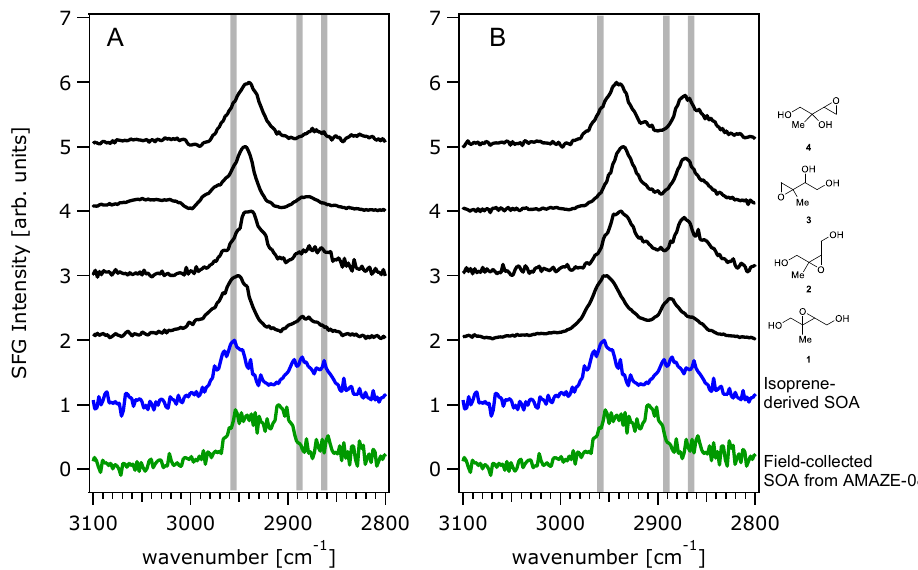
Fig. 2. ssp-Polarized SFG spectra of vapor-phase (left) and spin-coated (right) epoxides in contact with fused silica and comparison to synthetic isoprene-derived SOA particles (blue) and SOA particles collected in the central Amazon Basin (green). From top: α -IEPOX (4), δ -IEPOX (3), cis- β -IEPOX (2), trans - β -IEPOX (1), synthetic isoprene-derived SOA, and natural SOA from the central Amazon Basin. Gray vertical lines indicate (from left) CH 3 asymmetric, CH 3 symmetric, and CH 2 symmetric stretches. Spectra are offset for